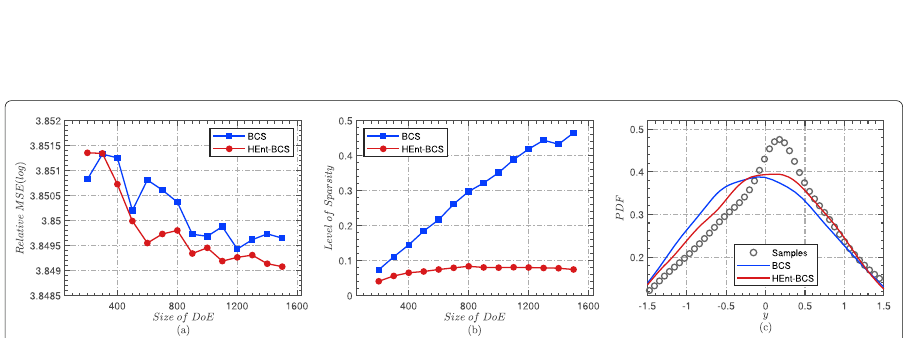
Fig. 13 Performance comparison of BCS, Ent-BCS and HEnt-BCS w.r.t. the high-dimensional function. ( a ) The relationship between the relative MSE and the size of DoE; ( b ) The relationship between the sparsity level of several methods and the size of DoE; ( c ) Enlarged details of the reconstructed